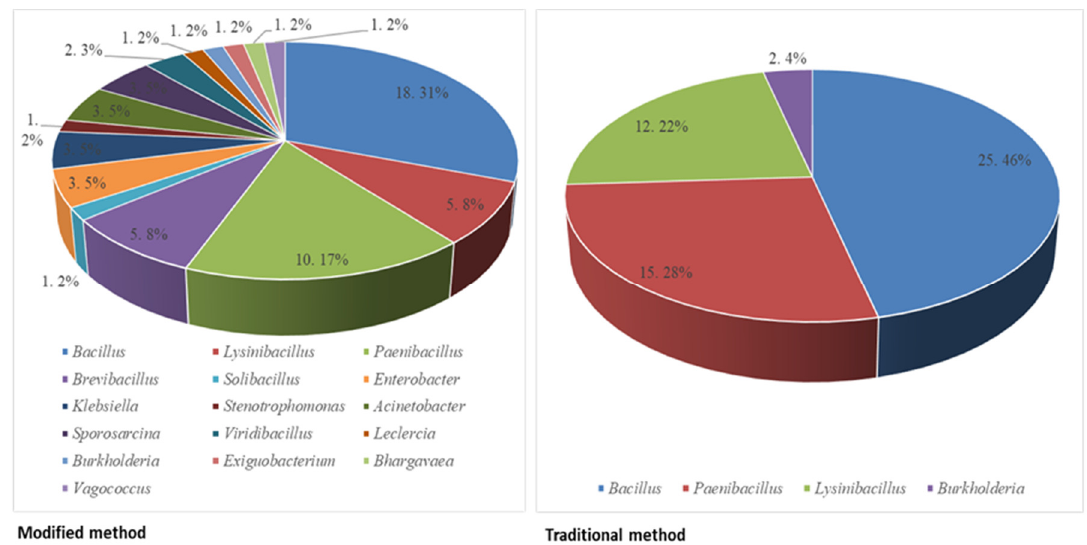
Figure 1. The diversity of bacterial strains investigated from the modified culture method compared to the traditional method.